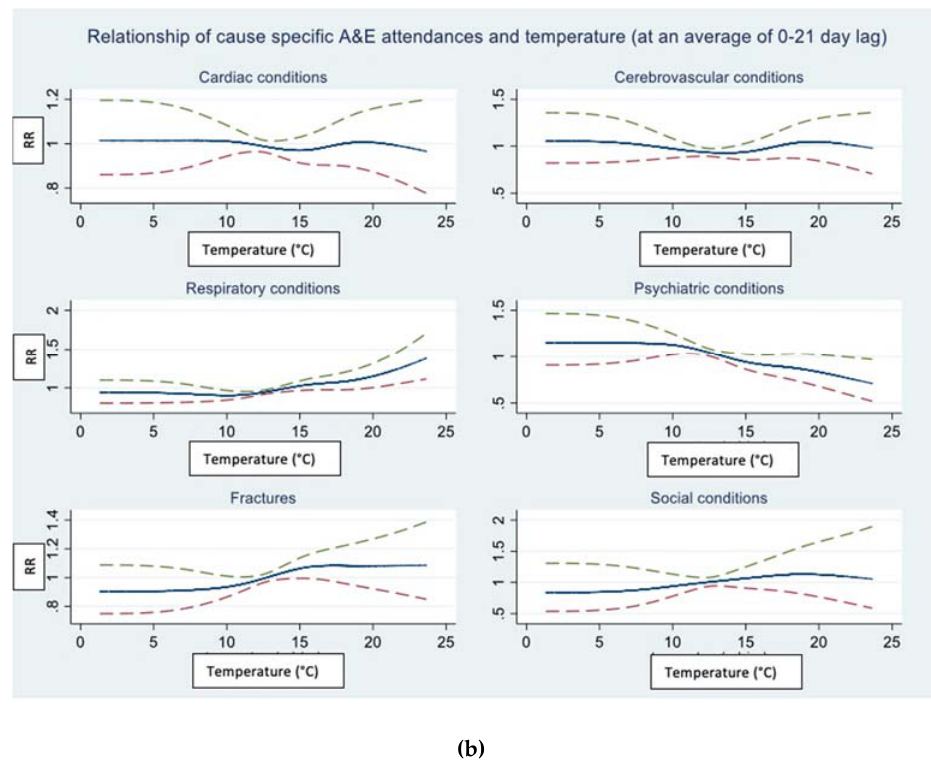
Figure 2. Relations between daily mean temperature and A&E department attendance by cause. The model is adjusted for seasonality, trend and day of the week. Temperature ( ◦ C) on the x-axis modelled with ( a ) 0- to 2-day lag and ( b ) 0- to 21-day lag and relative risk (RR) on the y-axis.